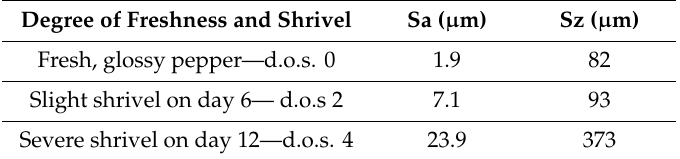
Table 1. Roughness values Sa and Sz (in μ m) of green pepper fruit during 2 weeks storage Degree of Freshness and Shrivel Sa ( μ m) Sz ( μ m) Fresh, glossy pepper—d.o.s.